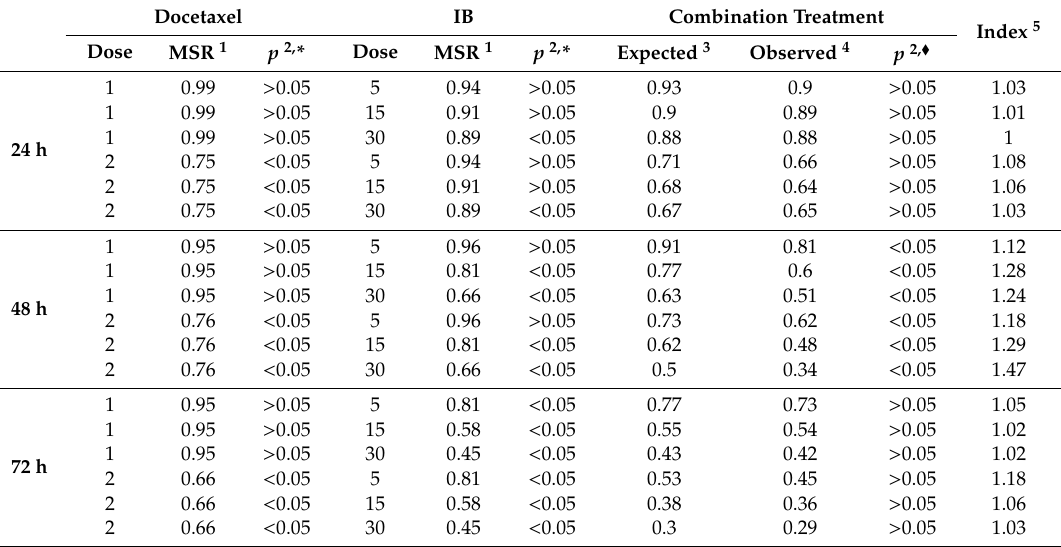
Table A5. Analysis of synergy between IB and DOCE calculated by survival rate for PC-3 cells.